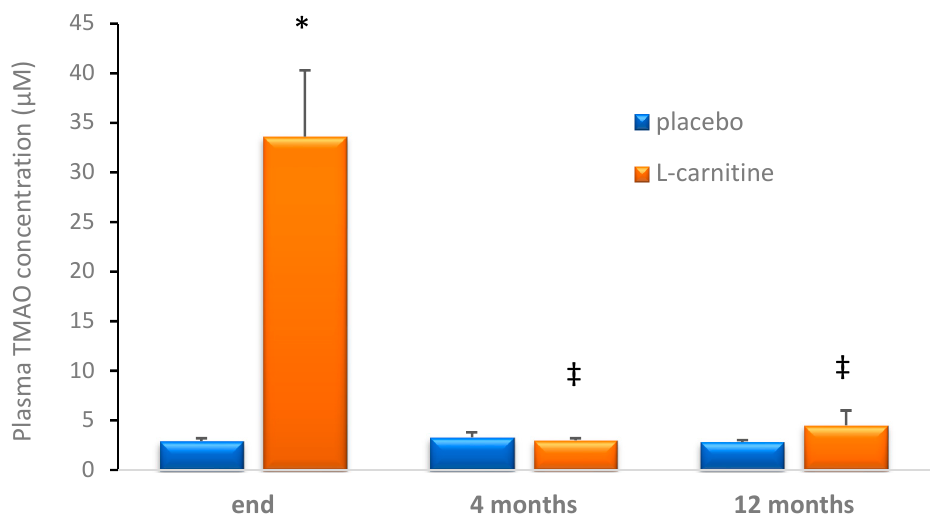
Figure 2. Plasma trimethylamine-N-oxide (TMAO) concentrations in placebo and L-carnitine groups. * p < 0.001 as compared to placebo group at the same time point, ‡ p < 0.001 as compared to the end of supplementation in the same group.